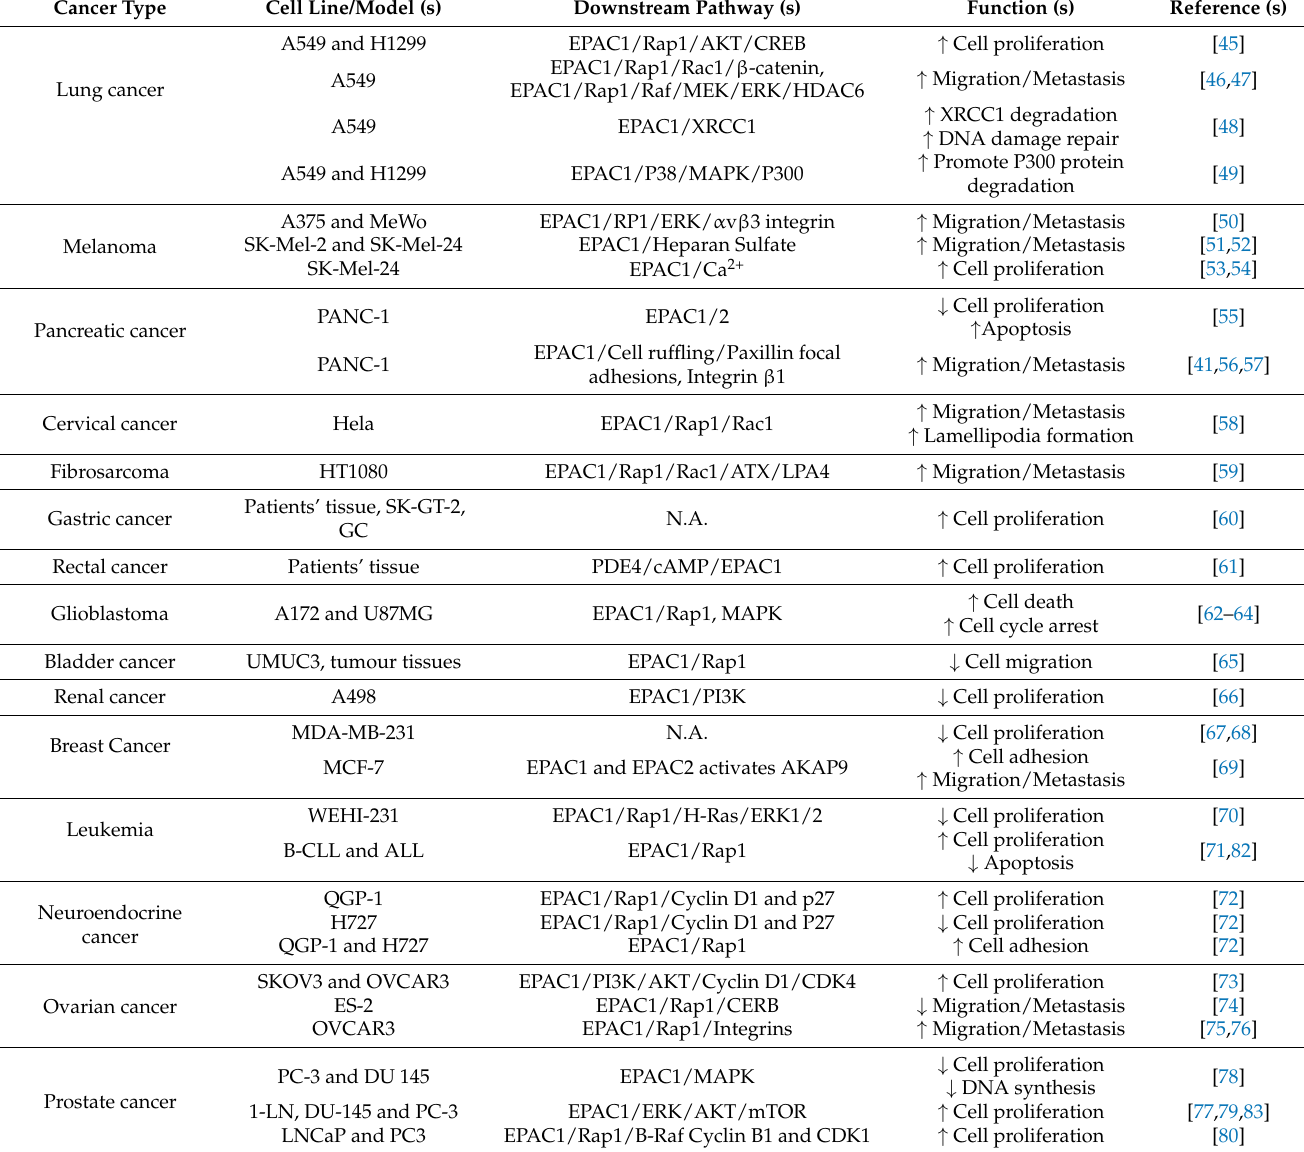
Table 1. EPACs functions in tumour development ( ↑ refers to up-regulation, ↓ refers to